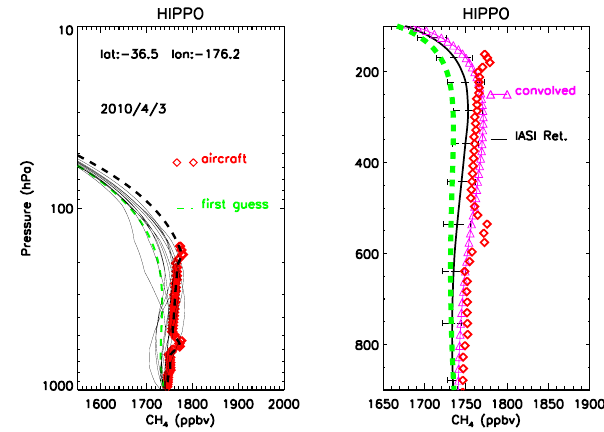
Fig. 7. A CH 4 profile on 3 April 2010 by HIPPO-3 aircraft measure- ment (red dots) vs. all IASI retrievals in a collocation window with a distance of 200km and on the same day. The right panel is the mean profile of IASI retrievals with the bars showing the standard devia- tion, the aircraft measurements smoothed with the averaging kernels (AK) (pink, triangles), and the first guess profile (green dash